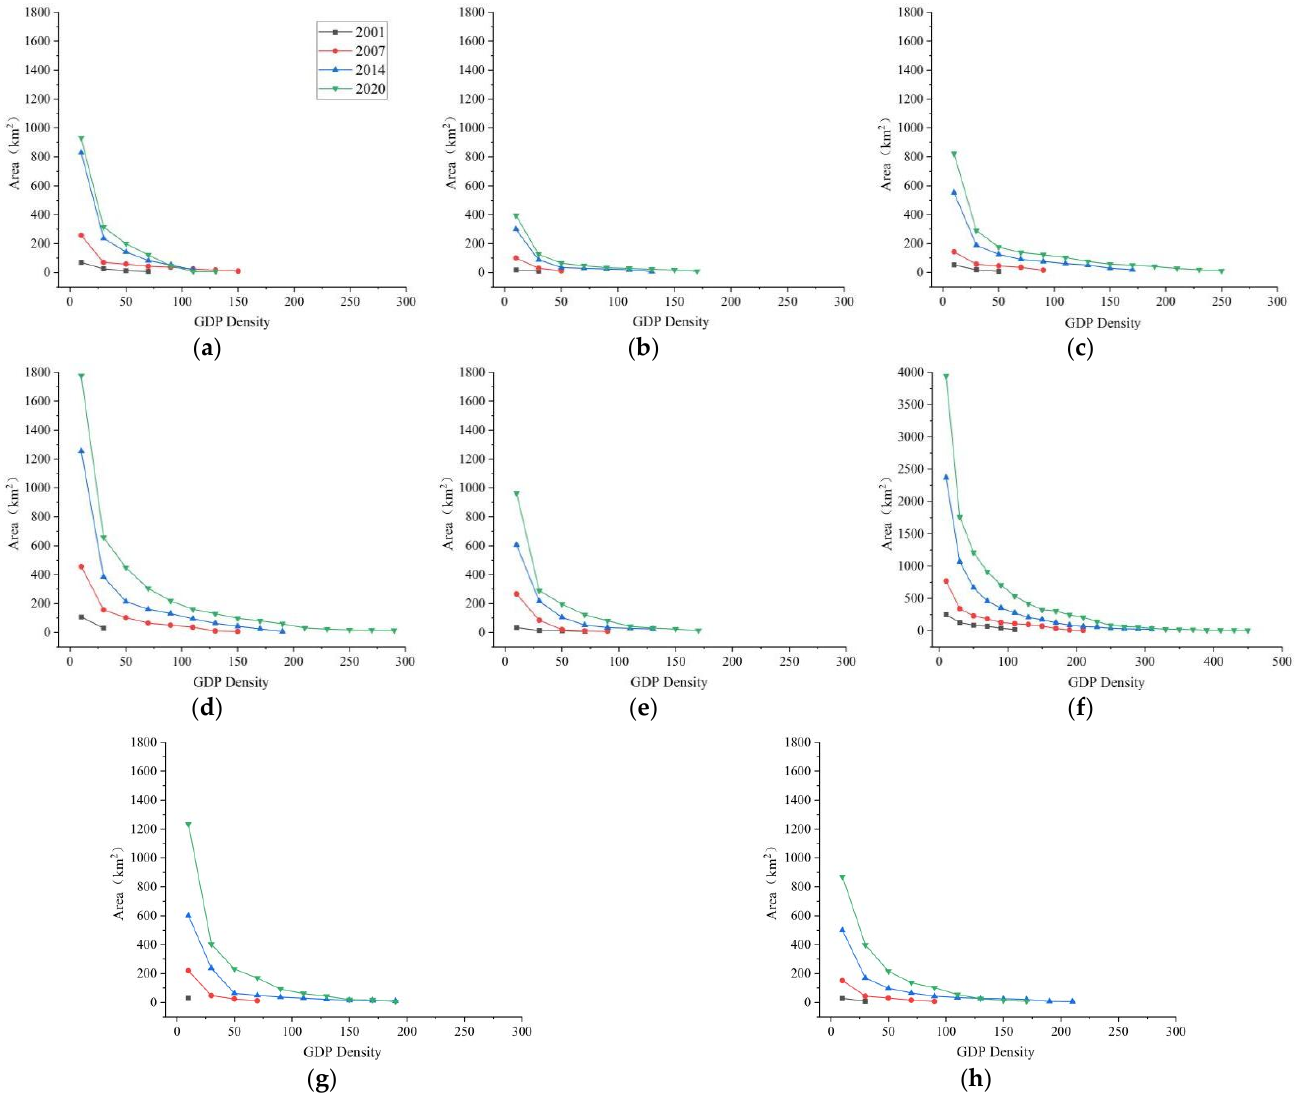
Figure 13. Total areas of the different levels of connected components in eight cities: ( a ) Anyang, ( b ) Hebi, ( c ) Kaifeng, ( d ) Luoyang, ( e ) Pingdingshan, ( f ) Zhengzhou, ( g ) Zhoukou, and ( h ) Zhumadian.